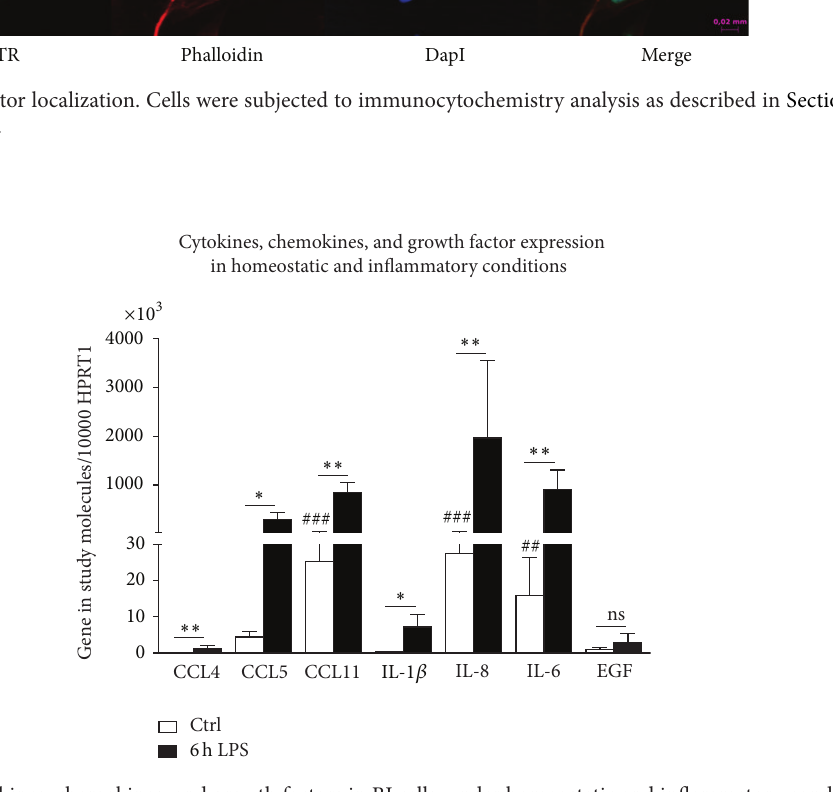
Figure 3: Expression of cytokines, chemokines, and growth factors in BJ cells, under homeostatic and inflammatory conditions. Cells were plated at 8 × 10 5 cells/dish in 60 mm dishes in a final volume of 6 mL of medium and treated with 1 𝜇 g of LPS during 6 h (LPS), or left untreated (Ctrl), at 37 ∘ C, with 5% CO 2 . Total RNA was isolated and retrotranscribed as indicated in Section 2. The mRNA levels were assessed by quantitative real-time RT-PCR. Gene expression is indicated as genes studied/10 000 molecules of the reference gene HPRT1. Values represent the mean ± SD from four independent experiments. Kruskall-Wallis test followed by Dunn’s posttest statistical analysis was performed between cytokines, chemokines, and growth factor expression under homeostatic and inflammatory conditions ( ∗∗ 𝑃 < 0.01 ; ∗∗∗ 𝑃 < 0.001 ) and among cytokines, chemokines, and growth factor expression under homeostatic conditions ( ## < 0.01; ### < 0.001). IL: interleukin; EGF: epidermal growth